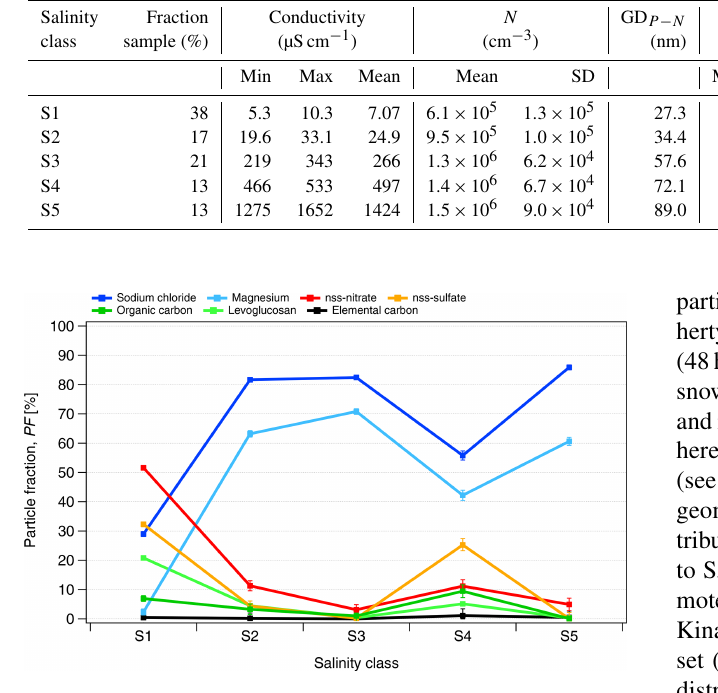
Figure 3. The number fraction of analyzed particles (PF) containing the given chemical species measured by ALABAMA in the PAS- CAL snow samples as a function of the salinity classes (Sn). The selected species are sodium chloride (NaCl), non-sea-salt (nss) ni- trate, nss sulfate, magnesium (Mg), levoglucosan and dicarboxylic acids, organic carbon (OC) and elemental carbon (EC). The chem- ical composition is measured for particles in the 110–5000nm di- ameter